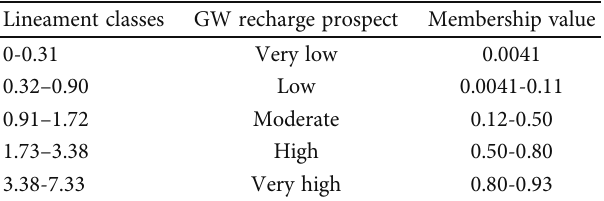
Table 7: Lineament density classes, membership value, and distribution.